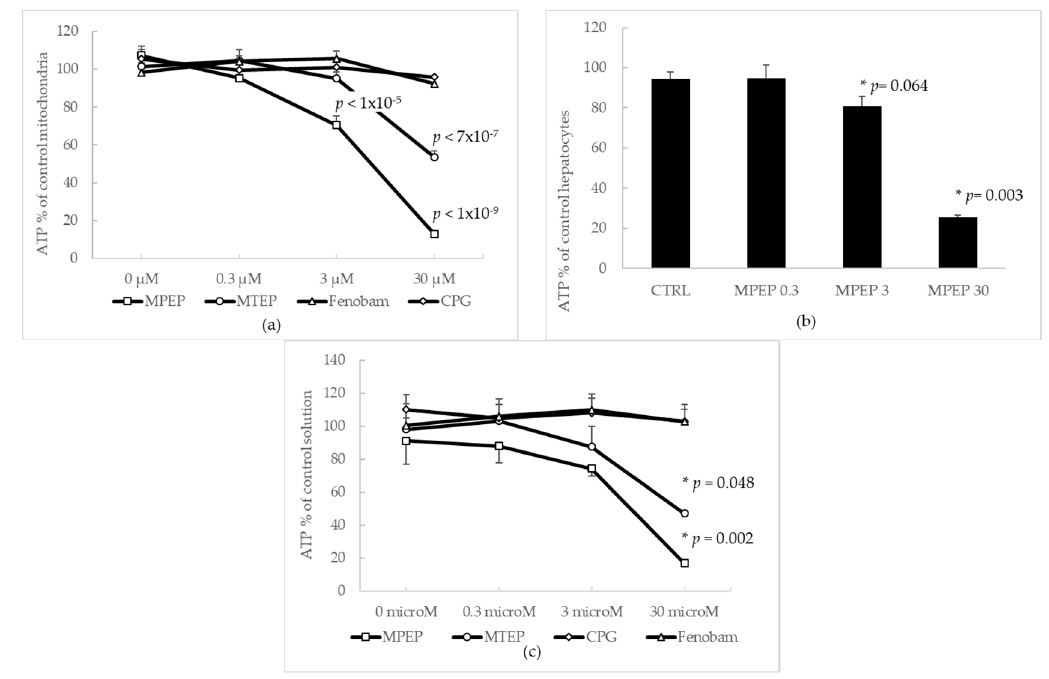
Figure 1. MPEP and MTEP deplete ATP from isolated mitochondria, primary hepatocytes, and acellular, ATP-containing solutions. ( a ) MPEP and MTEP reduce ATP content in a suspension of isolated hepatic mitochondria, in a dose dependent way, to 13.0 ± 1.3% and 53.7 ± 12.5% with respect to control mitochondria. Fenobam and CPG did not show any effect. DHPG did not alter ATP content [15]; ( b ) In primary rat liver hepatocytes, MPEP dose-dependently reduced ATP concentration, producing a near-significant effect at 3 µM and a markedly significant effect at 30 µM ( p = 0.003). At 0.3 µM MPEP did not reduce ATP concentration in freshly isolated hepatocytes. DHPG did not alter ATP content [15]; ( c ) 10 µM ATP was added to a plain PBS buffer. ATP was significantly reduced by the addition of MPEP (16.8 ± 0.5% of control solution at 30 µM) and MTEP (47.1 ± 1.7% of control solution, at 30 µM) but not fenobam or CPG, reproducing the same trend observed in ( a ). The asterisk indicates a significant difference (Tukey’s Test) with respect to controls (0 µM).